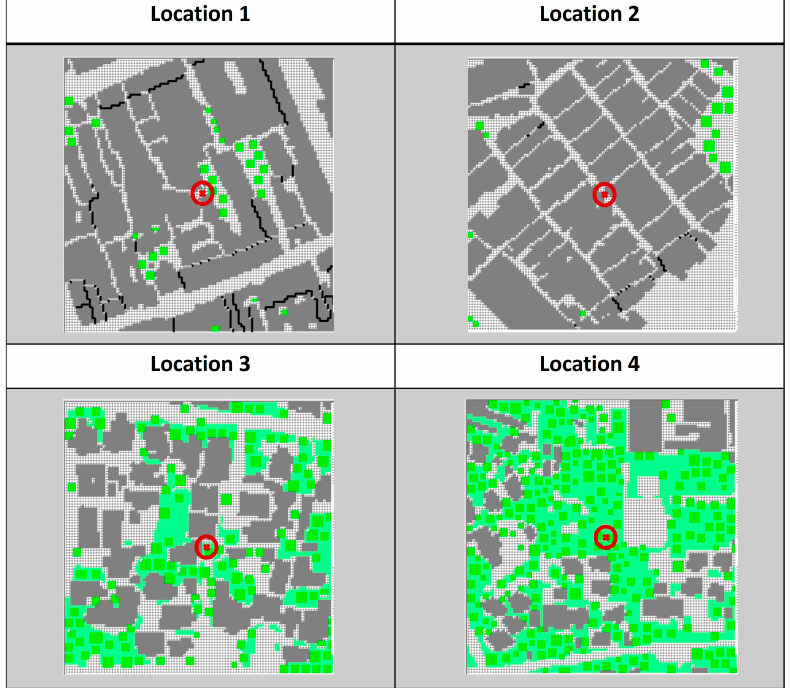
Figure 6. Simulation models for the base cases with red circles representing locations of data collection.